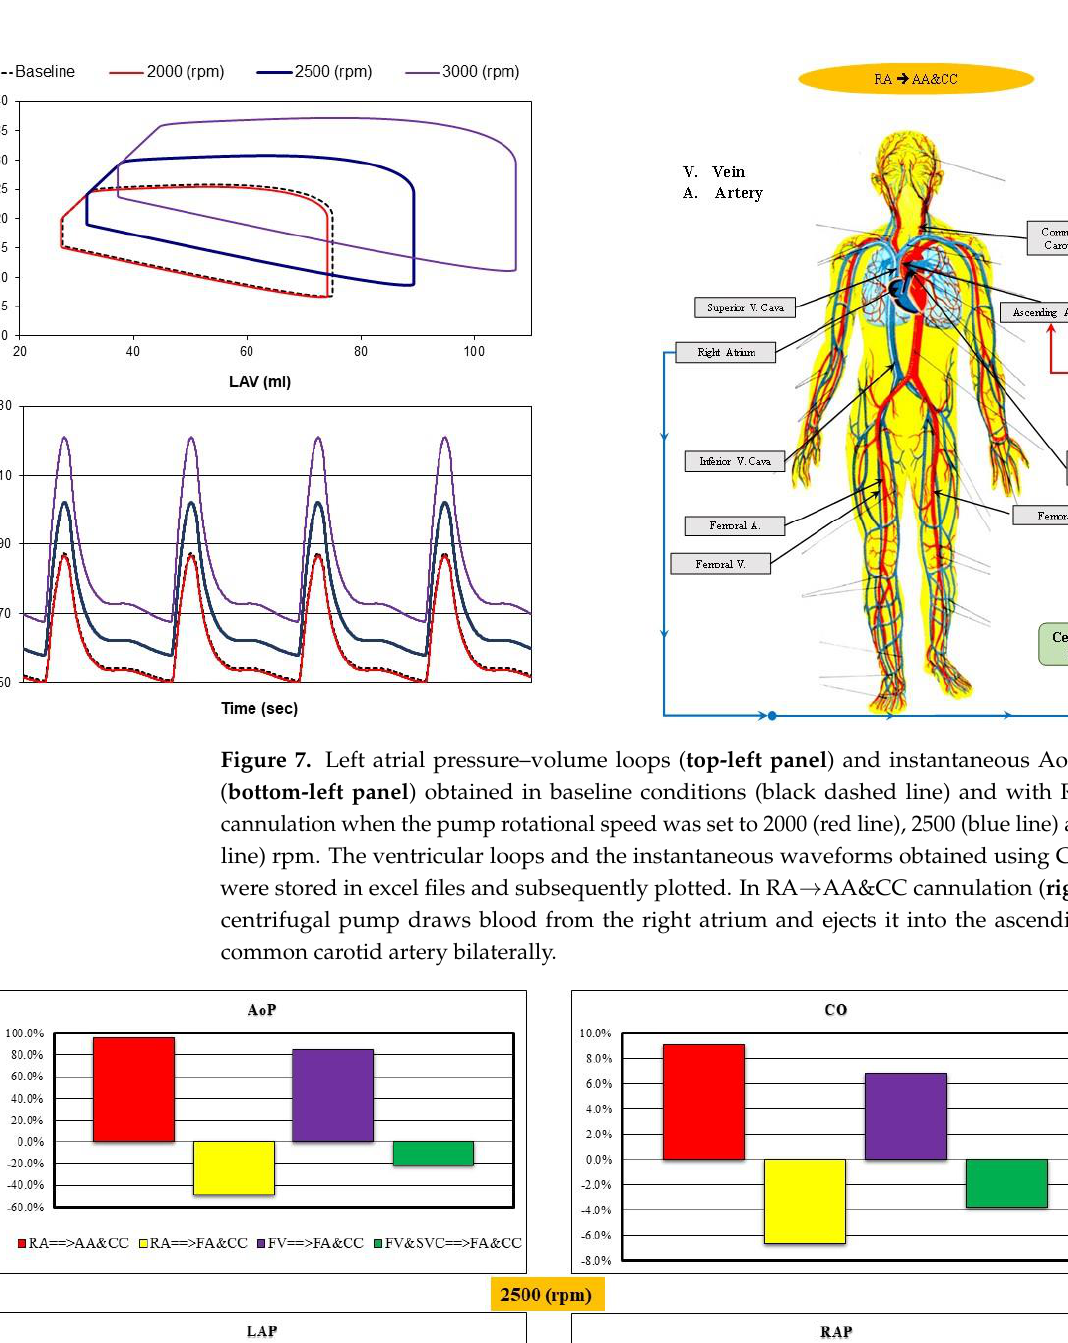
Figure 9. Relative CO changes calculated in comparison to baseline conditions for the four different cannulation strategies at different pump rotational speed. The top ( bottom ) -left panel shows the relative changes in CO induced by RA → AA&CC (FV&SVC → FA&CC) cannulation. The top ( bot- tom ) -right panel shows the relative changes in cardiac output induced by RA → FA&CC (FV → FA&CC) cannulation.